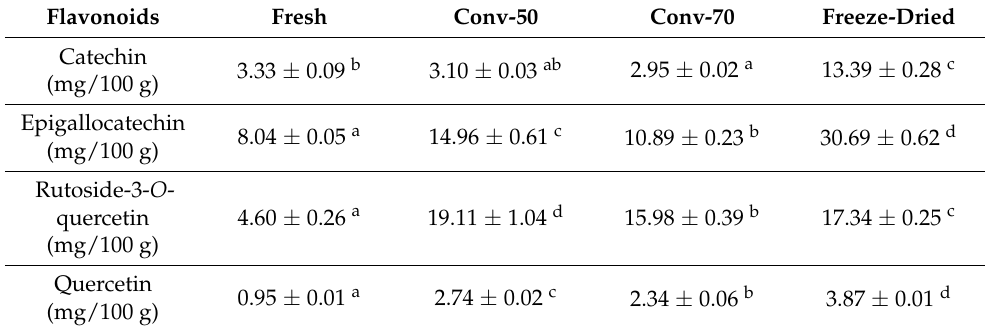
Table 4. The content of selected flavonoids in fresh and dried quinces.